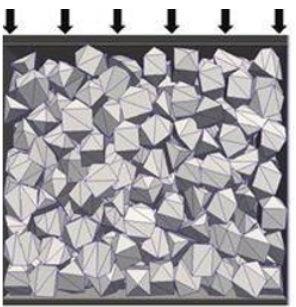
Fig. 3. Numerical sample of grains.